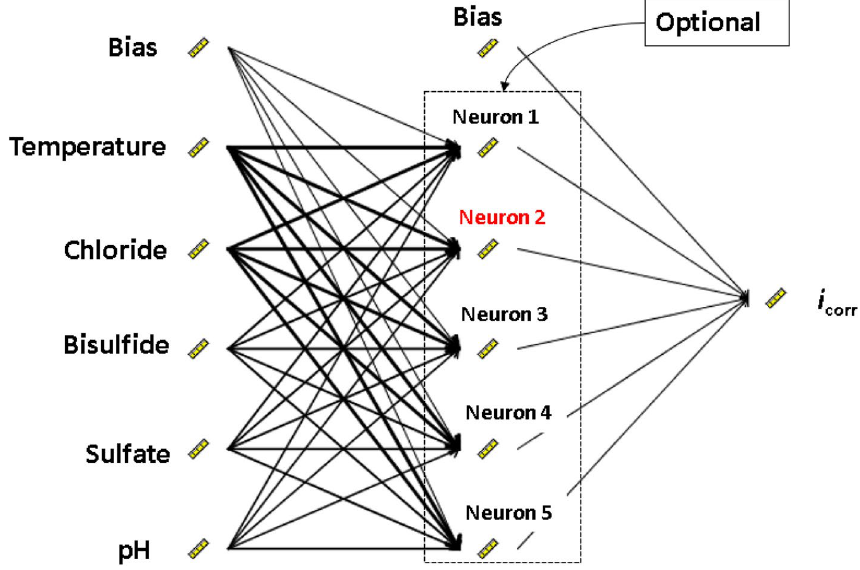
Figure 7. ANN architecture for predicting external corrosion current density of carbon steel in